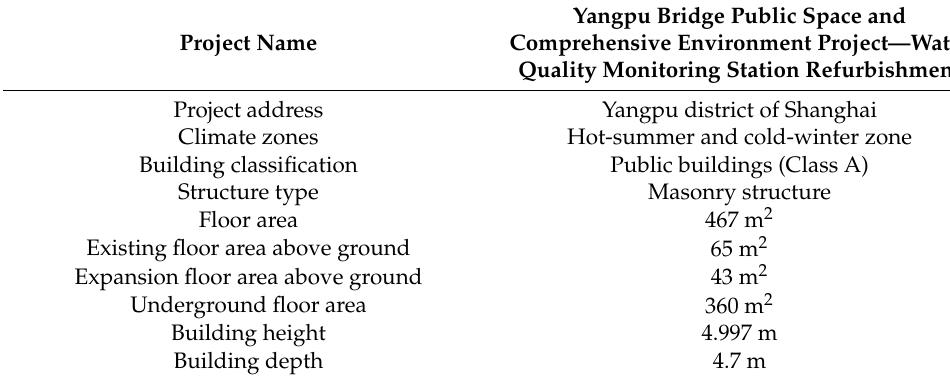
Table 1. Detailed information about the studied